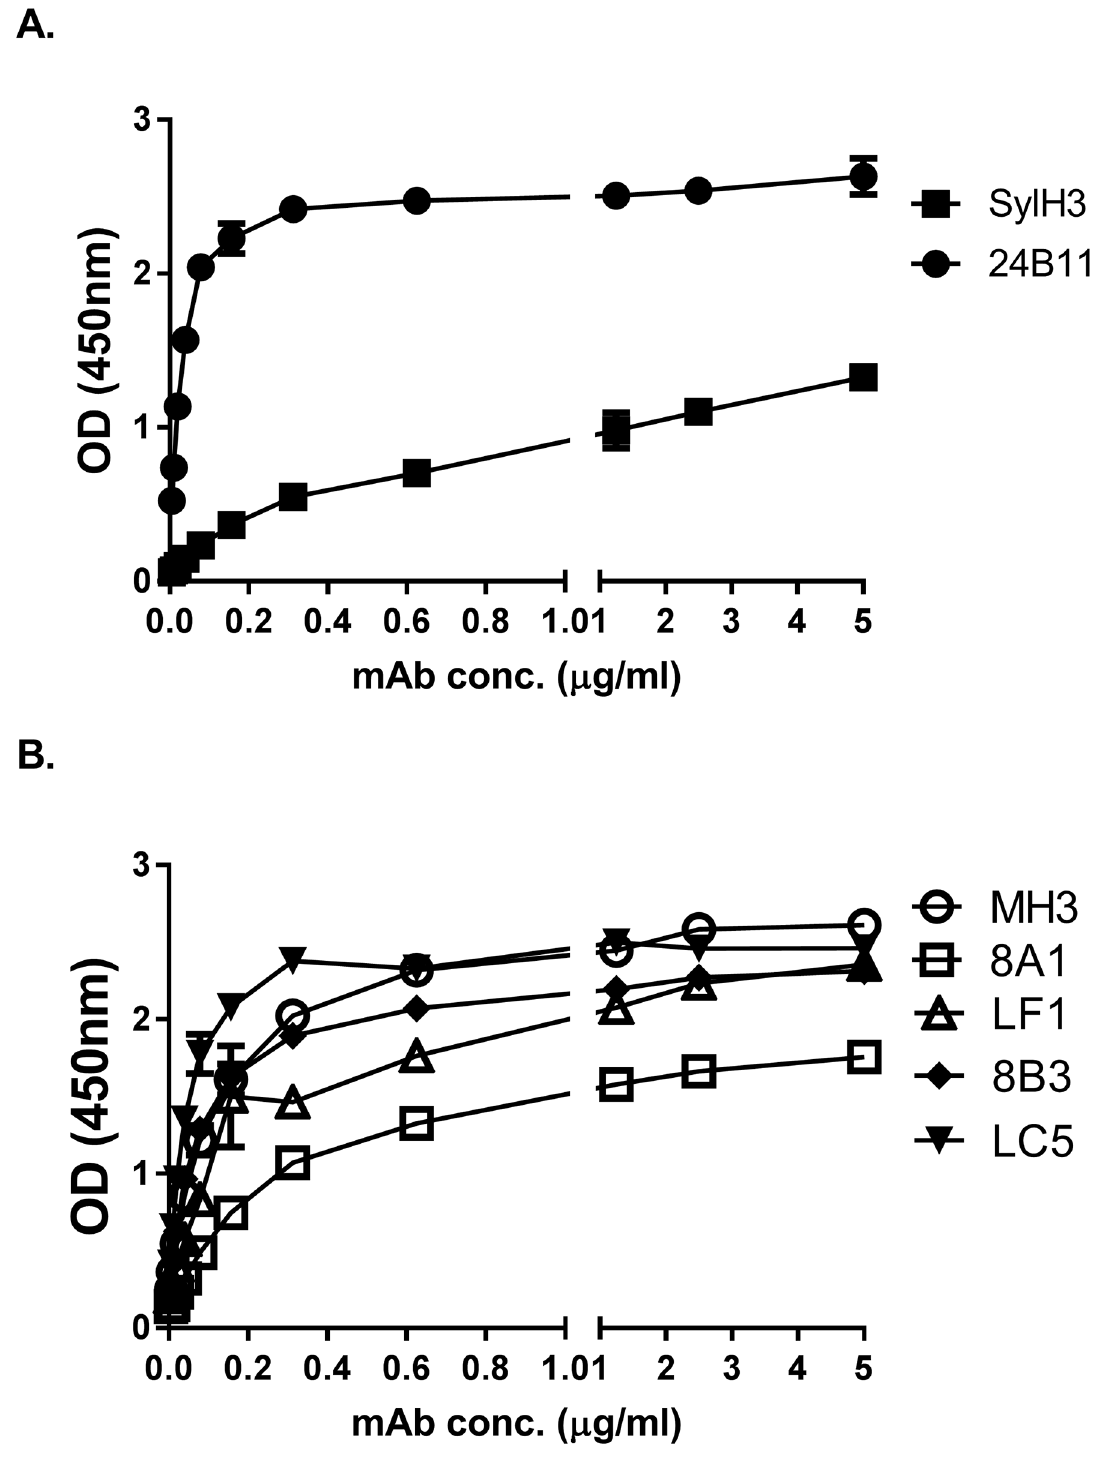
Fig 3. Recognition of receptorbound RTB by MH3, 8A1, 8B3, LF1, and LC5. Ninety-six well microtiter plates were coated with ASF-RTB and then probedwith indicatedmAbs (starting at 5 μ g/ml): (top panel) SylH3 and 24B11 ;(bottom panel) MH3 , 8A1 , LF1, 8B3, and LC5. The results shown are a singlerepresentative experiment in which each sample was done in duplicate. Error bars, when visible, reflect the